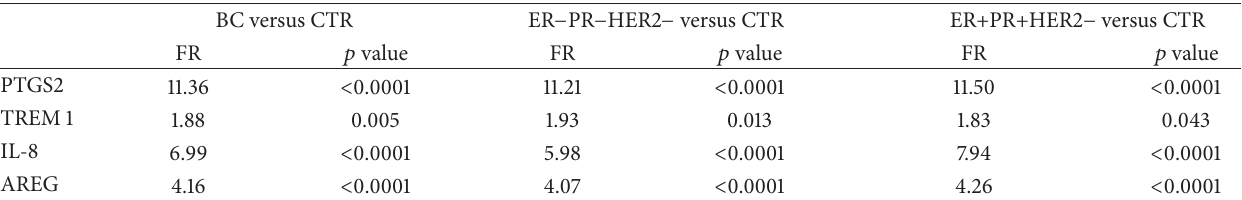
Table 4: Relative expression of PTSG2, TREM1, IL-8, and AGREG assessed by qRT-PCR in BC, ER − PR − HER2 − , and ER+PR+HER2 − samples. Statistical significance was assessed using one-way ANOVA followed by Tukey’s post hoc test. BC versus CTR ER − PR − HER2 − versus CTR ER+PR+HER2 − versus